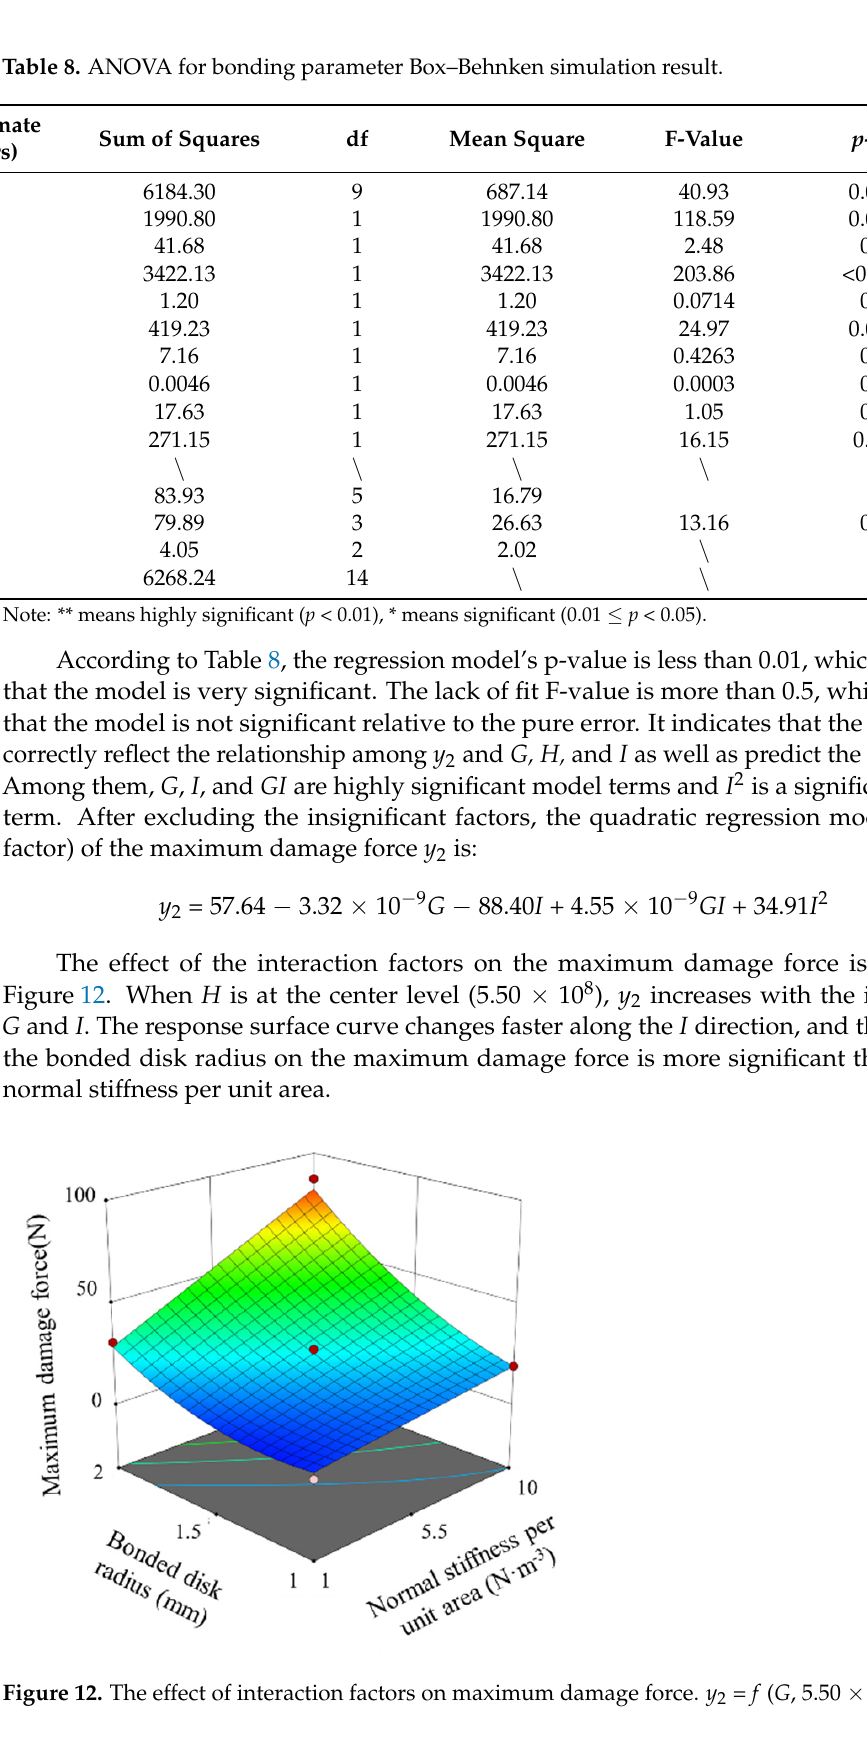
Figure 12. The effect of interaction factors on maximum damage force. y 2 = f ( G , 5.50 × 10 8 , I ).